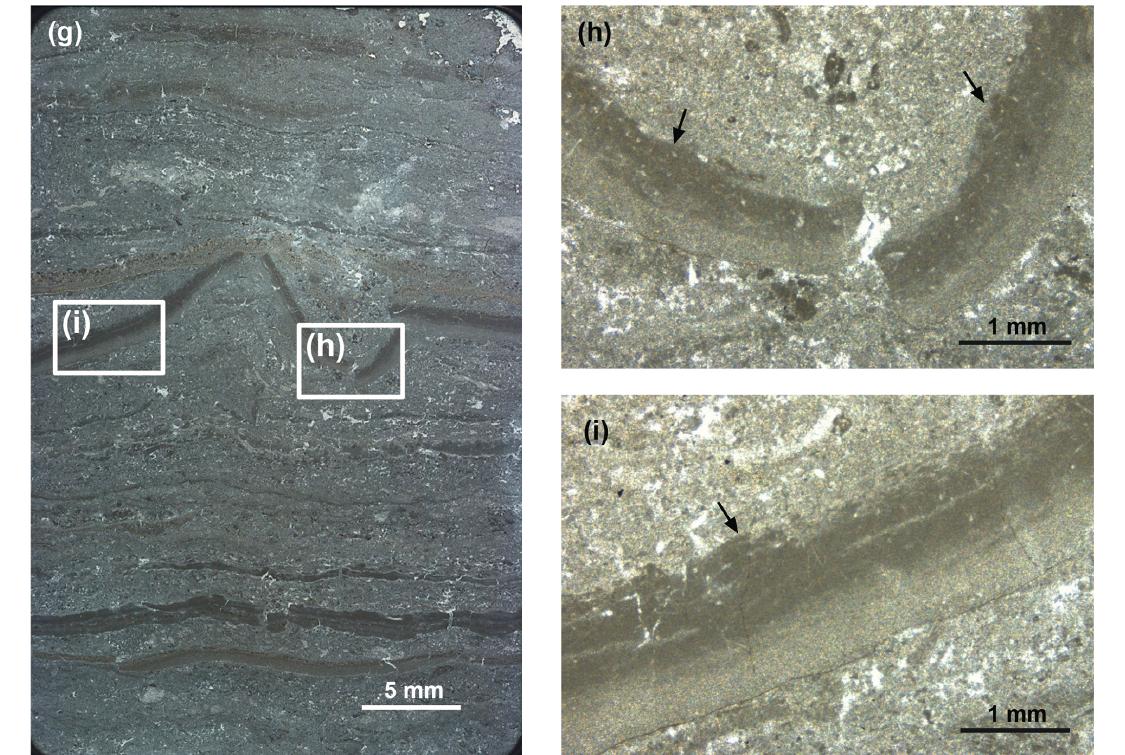
Figure 4. Photomicrographs of thin sections of dolomites of the Travenanzes Fm.: (a) rounded mud clasts embedded in dolomicrite matrix. The larger, millimetre-size intraclast in the upper left side of the image (arrow) consists itself of matrix with darker, embedded mud clasts (sample TZ16-St1; 104m). (b) Mud clasts in dolomicrite matrix. Mud clasts are deformed (e.g. arrow); layers of coarser (c) and finer matrix (f) are equally affected by plastic deformation (sample TZ16-22; 120m). (c, d) Pseudomorphs after gypsum in fine-grained dolomudstone (e.g. arrows). (e) Oolitic grainstone (sample TZ14-4; 64m). The cortices consist of microcrystalline dolomite and lack a radial structure, some showing a concentric structure (arrow). (f) Laminated dolomite showing pseudo-teepee structures (arrow). Vertical cracks are often, but not always, associated with pseudo-teepees (sample TZ14-10; 107m). Some coarser-grained laminae may contain microsparite and peloids (P with small arrows). (g) Laminated dolomite showing both plastic and brittle deformation of laminae. A centimetre-scale pseudo- teepee occurs in the centre of the image (sample TZ16-21; 107m). (h, i) Close-up of graded lamina in (g) showing plastic deformation. The top of the lamina shows an erosion surface with small rip-up clasts (arrow), overlain by a coarser